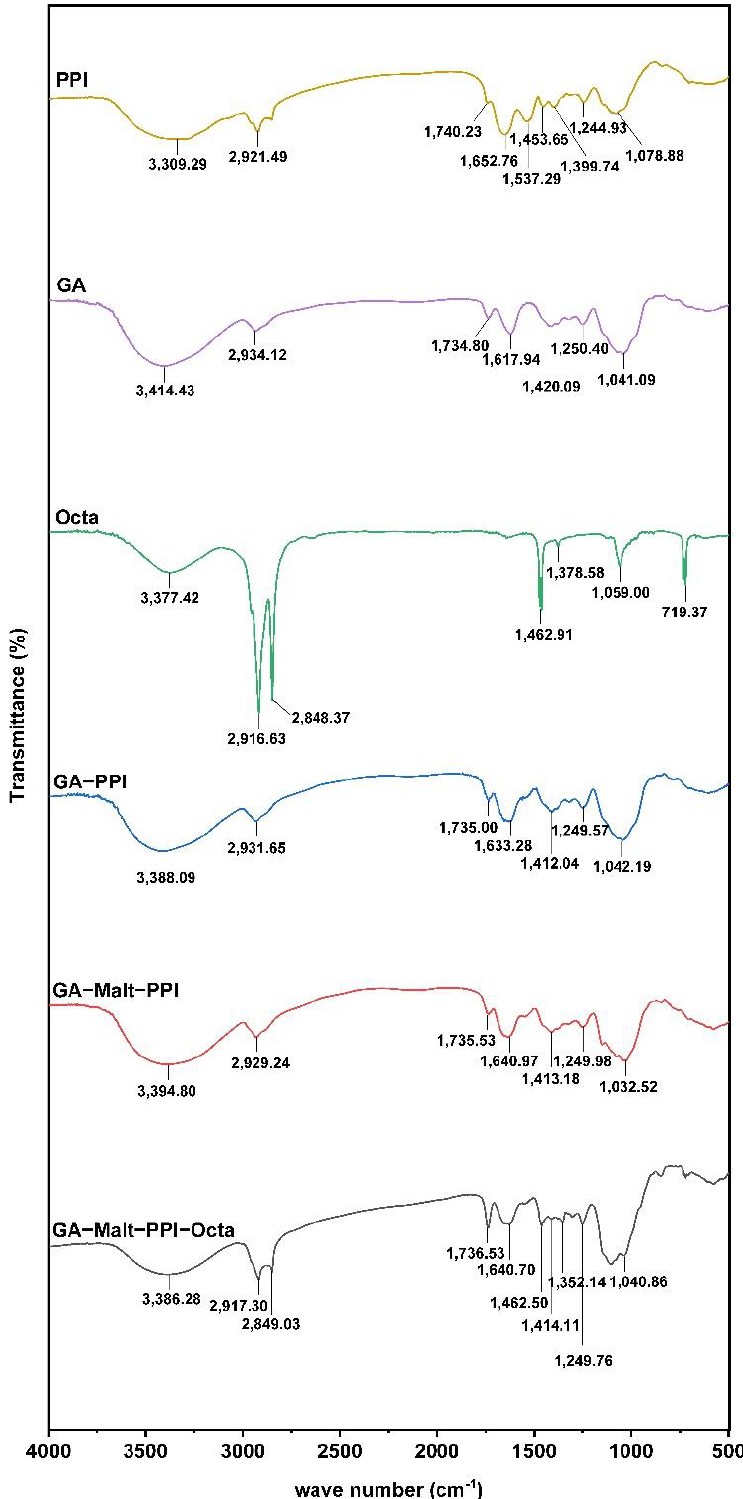
Figure 2. FTIR spectra of PPI, GA, Octa, GA − PPI, GA − Malt − PPI, and Octa − GA − Malt − PPI.